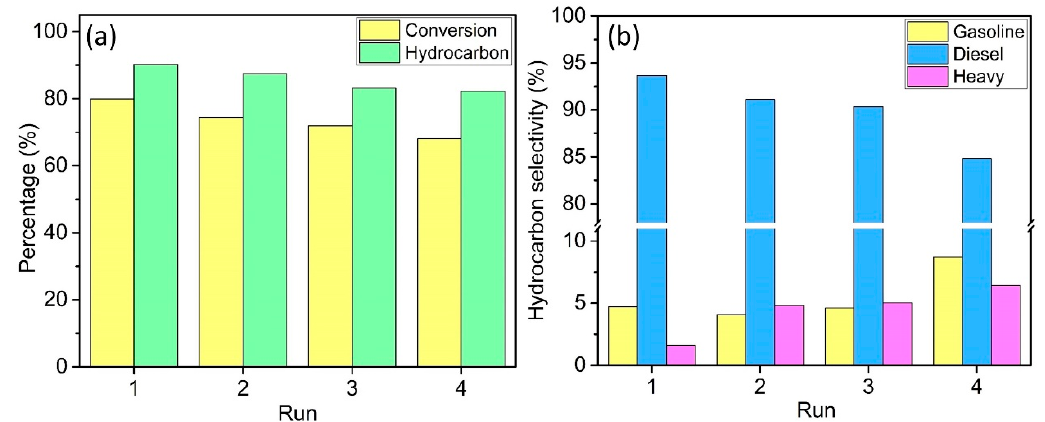
Figure 8. Reusability study of ( a ) conversion and hydrocarbon product and ( b ) hydrocarbon selectivity from deoxygenation of triolein over DP-Y65. Reaction conditions: temperature 380 °C, time 1 h, catalyst loading 7 wt%, pressure 10 mbar, and stirring speed 400 rpm.